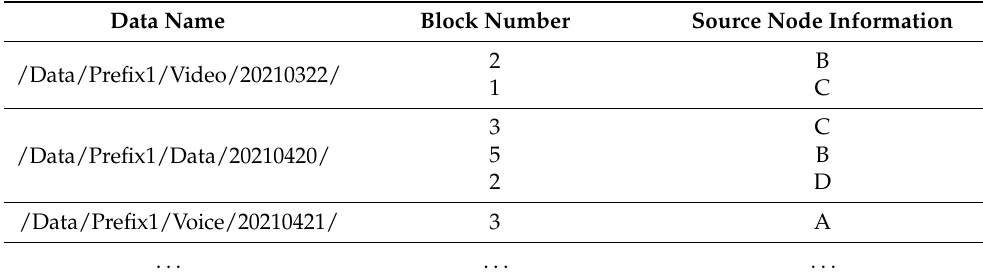
Table 4. Summary of published